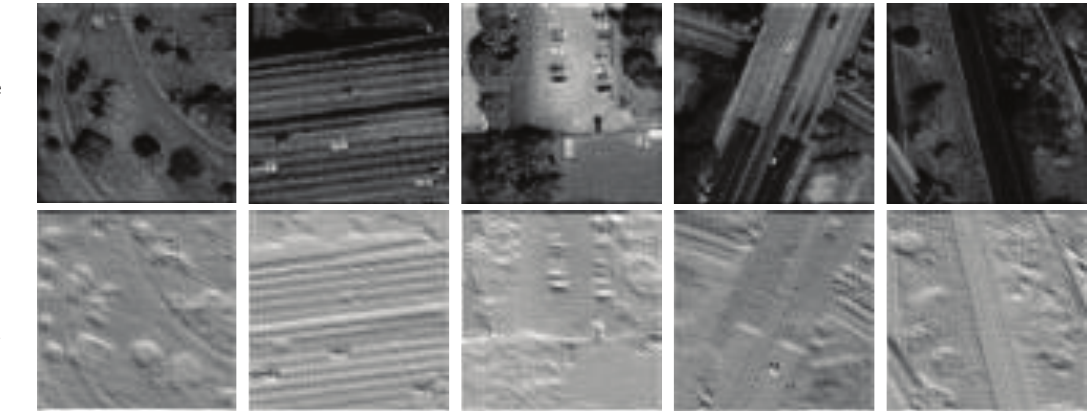
Figure 3. Attention-augmented results.